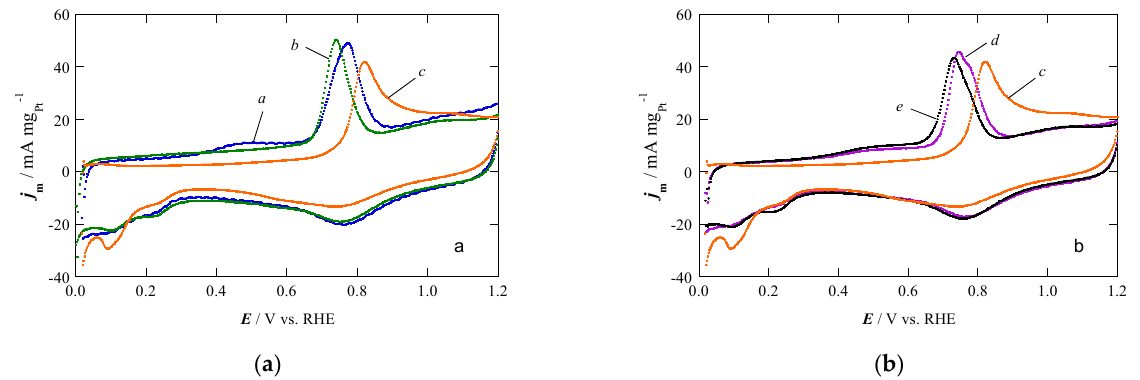
Figure 4. CO stripping curves in deaerated 0.5 mol dm − 3 H 2 SO 4 solution at a scan rate of 20 mV s − 1 . ( a ) Pt(Cu)/CMK3 (curve a ), Pt(Cu)/CMK3-A ( b ), and Pt/C ( c ); ( b ) Pt(Cu)CMK8 (curve d ), Pt(Cu)/CMK8-A ( e ), and Pt/C ( c ).